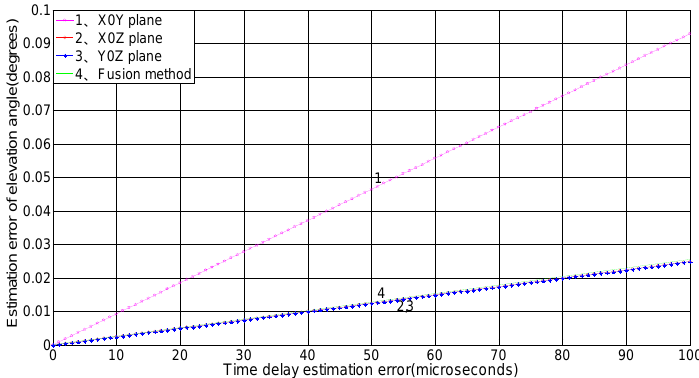
Figure 5. Relationship between the time-delay estimation error and elevation angle measurement precision.